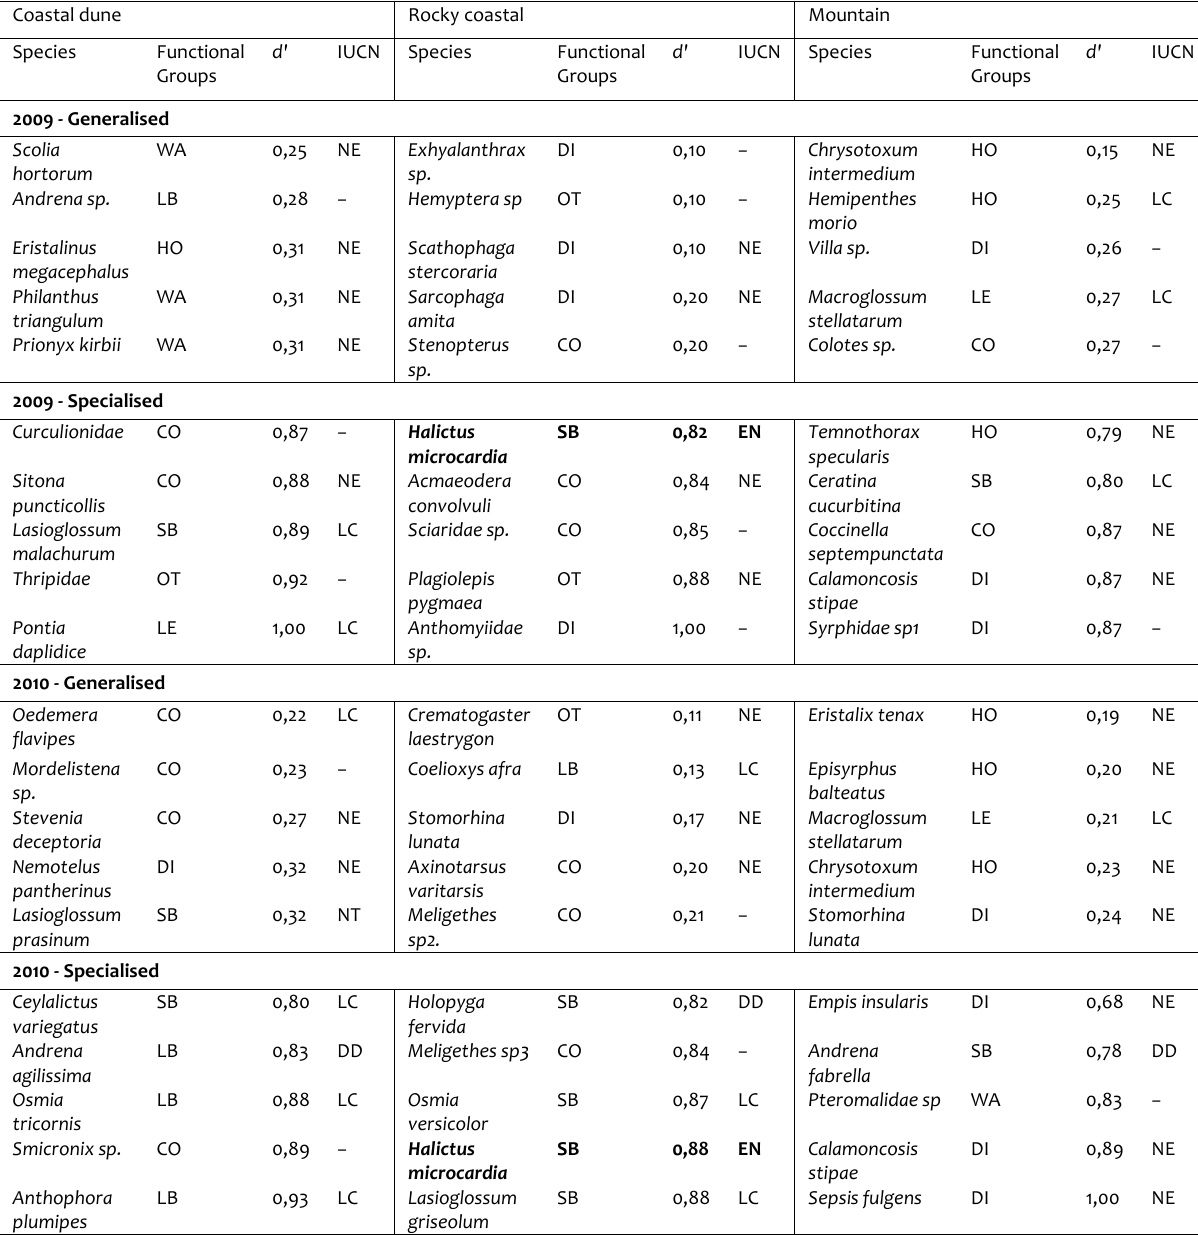
Table 2. Complementary specialisation index ( d’ ) of the five most generalised and specialised species in each year and community: Coastal dune community: Son Bosc. Rocky coastal community: Cala Mesquida and Mountain community: Puig Major. The IUCN status is given only for those taxa identified at the species level. The categories are DD (Data Deficient), EN (Endangered), LC (Least Concern), NE (Not Evaluated), and NT (Near Threatened). Species in bold are the endemic species to the Balearic